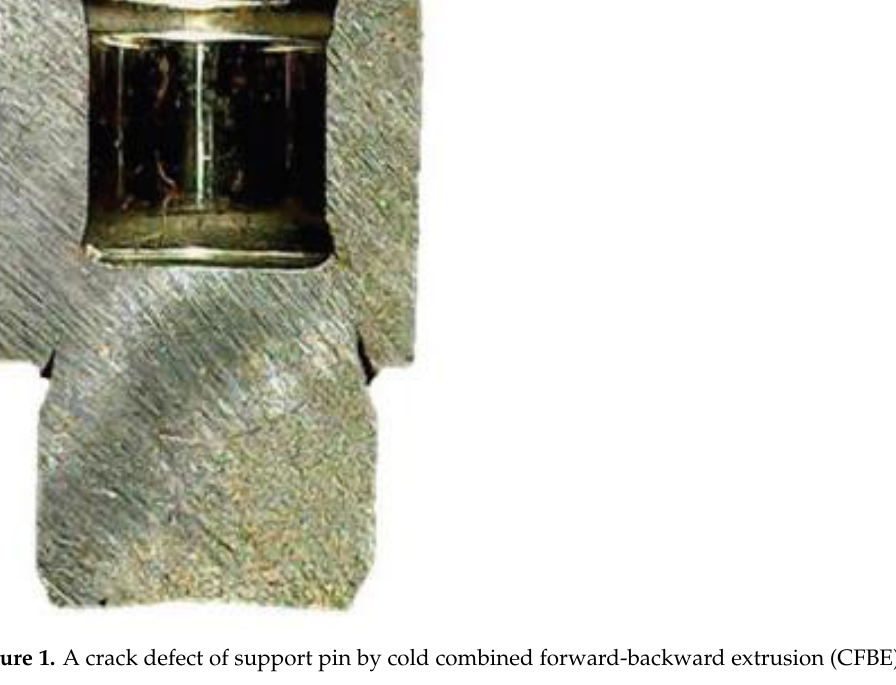
Figure 2. ( a ) Cracks appearing on side surface of a cold forged part; ( b ) sequence of cold forging operations [2]. Figure 3. Configuration of CFBE process, left: before extrusion; right: after extrusion.